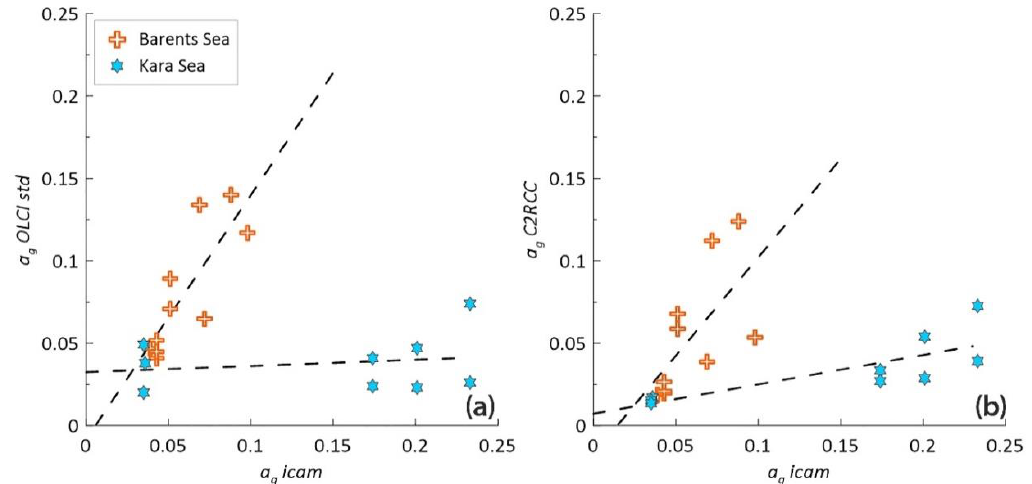
ICAM device for 13 stations. The solid line is 1:1 dependency. ( a ) — RSA algorithm (RMSE = 0.042, RE